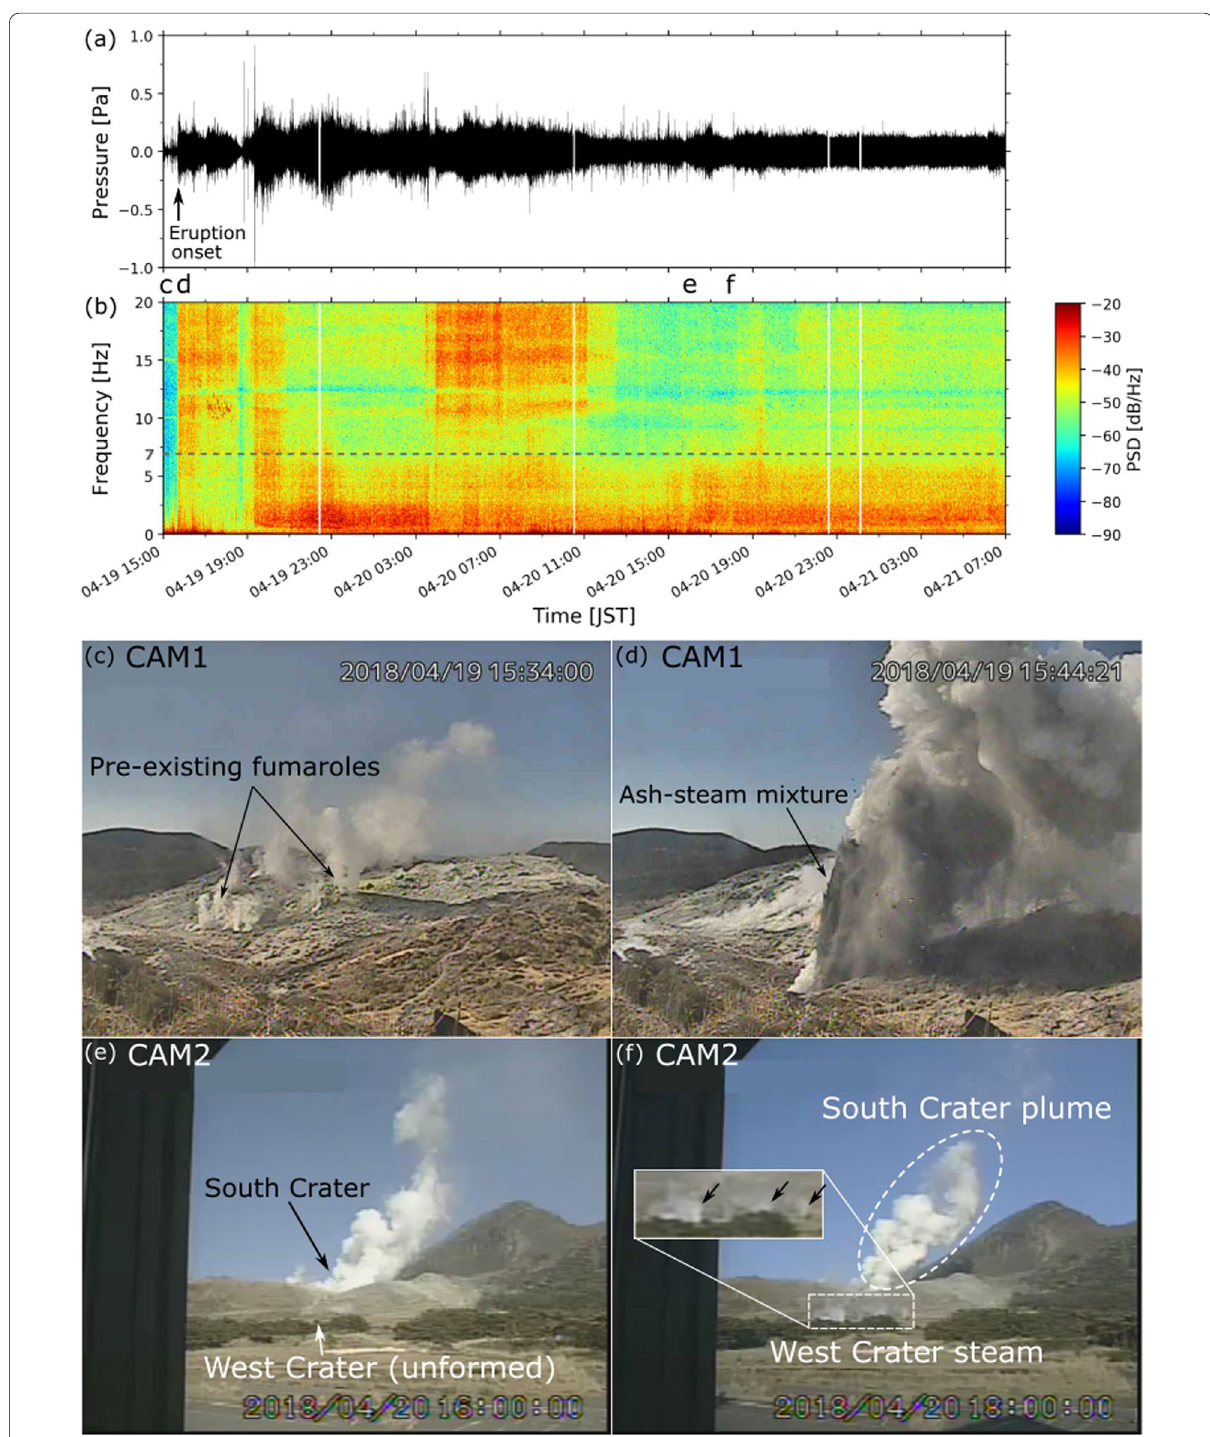
Fig. 2 Waveform and spectrogram of infrasound recorded by MC2 and the snapshots that captured surface phenomena associated with the eruption by CAM1 and CAM2. a Infrasound waveform filtered 0.3–20 Hz. The vertical white lines represent data-missing periods due to equipment problems. b Spectrogram of the nonfiltered infrasonic signal calculated using 10.24-s sliding windows with 50% overlaps. We observed infrasonic powers in two frequency bands separated at 7 Hz (gray dashed line). The middle panels show snapshots of the South Craters taken by CAM1 just prior to the eruption ( c ) and at the onset of the eruption ( d ). The bottom panels are snapshots taken by CAM2 that show the West Crater before the eruption ( e ) and emitting faint steam, which indicated by black arrows ( f